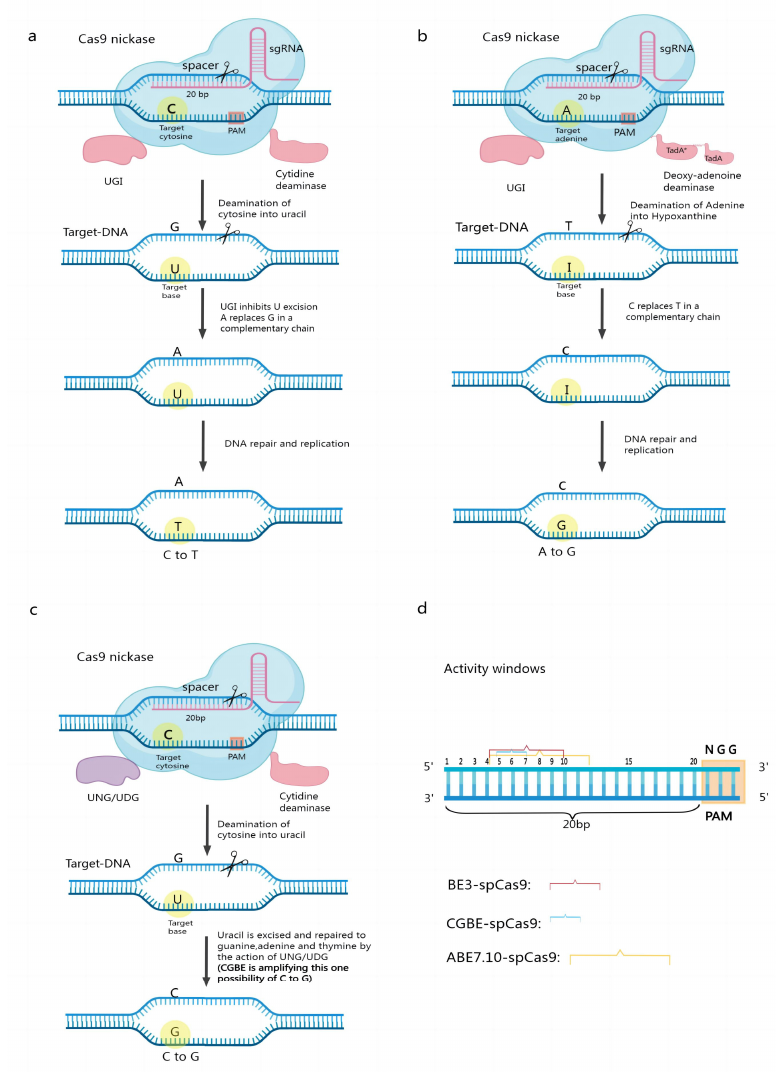
Figure 1. Mechanism of base editing work. ( a ) Structure and working mechanism of the cytosine base editor; ( b ) Structure and working mechanism of the adenine base editor; ( c ) Structure and editing mechanism of CGBE; ( d ) Window of activity for some typical CBEs, ABEs, and CGBEs.